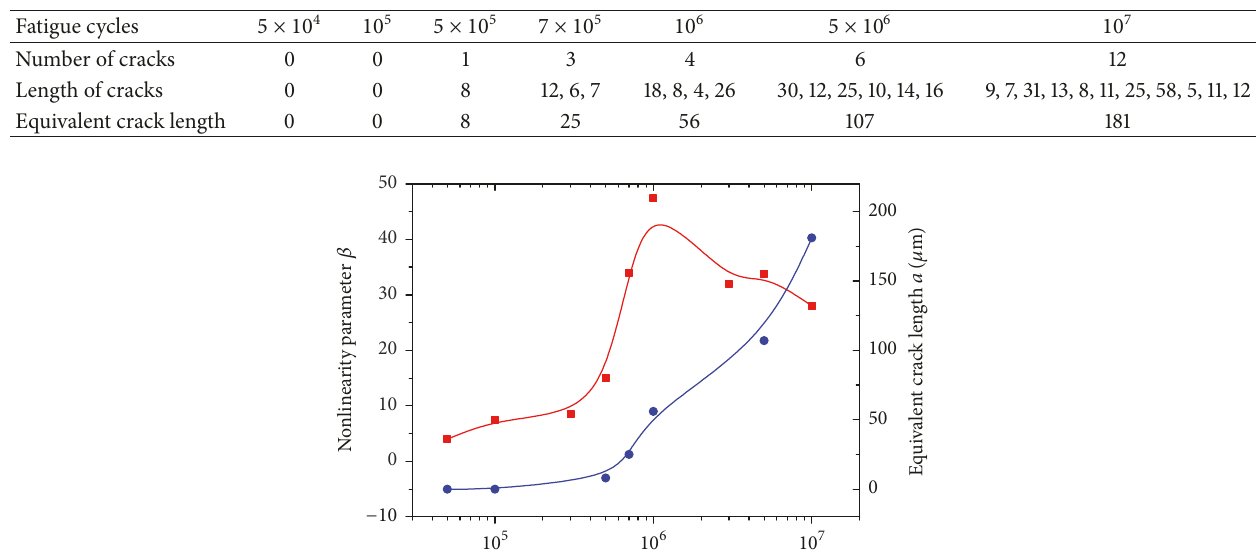
Table 4: Statistics of the cracks in the specimens.